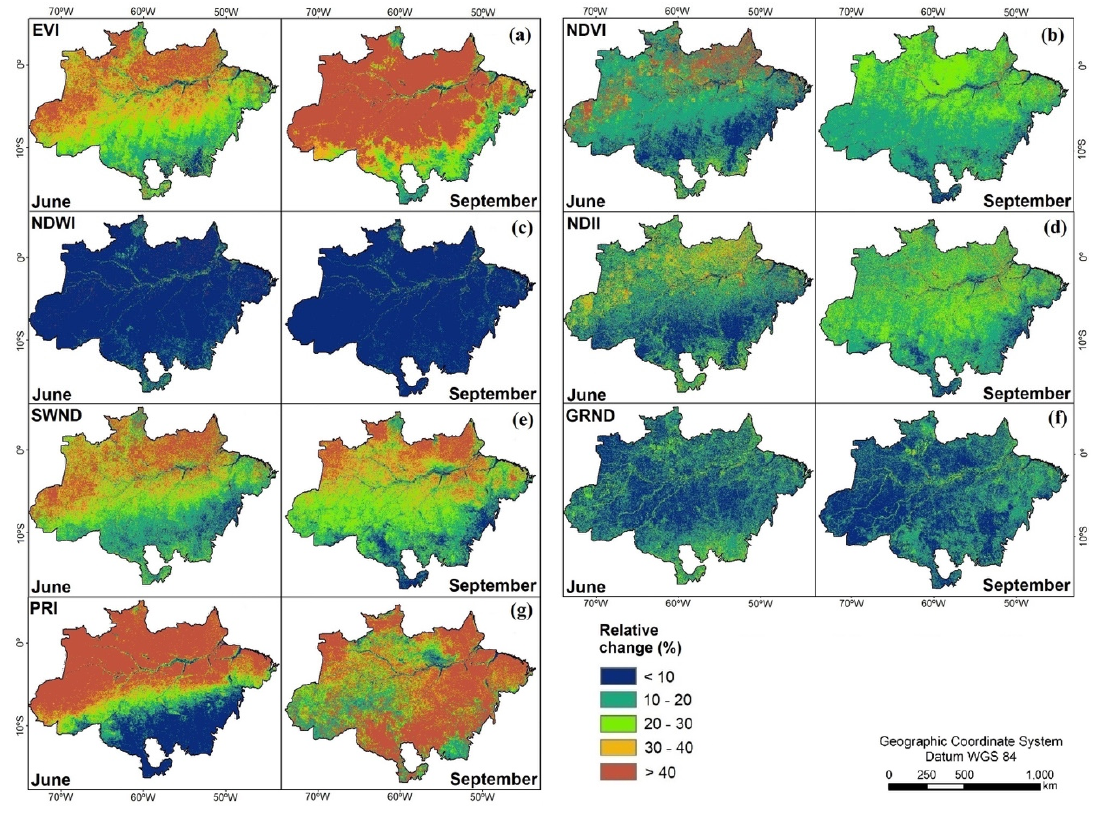
Figure 9. Monthly average relative changes (2000–2014) between BRDF–corrected and non–corrected ( a ) enhanced vegetation index (EVI), ( b ) normalized difference vegetation index (NDVI), ( c ) normalized difference water index (NDWI), ( d ) normalized difference infrared index (NDII), ( e ) shortwave infrared normalized difference (SWND), ( f ) green–red normalized difference (GRND), and ( g ) photochemical reflectance index (PRI). For each vegetation index, MODIS results are shown in the beginning (June) and end (September) of the Amazonian dry season.